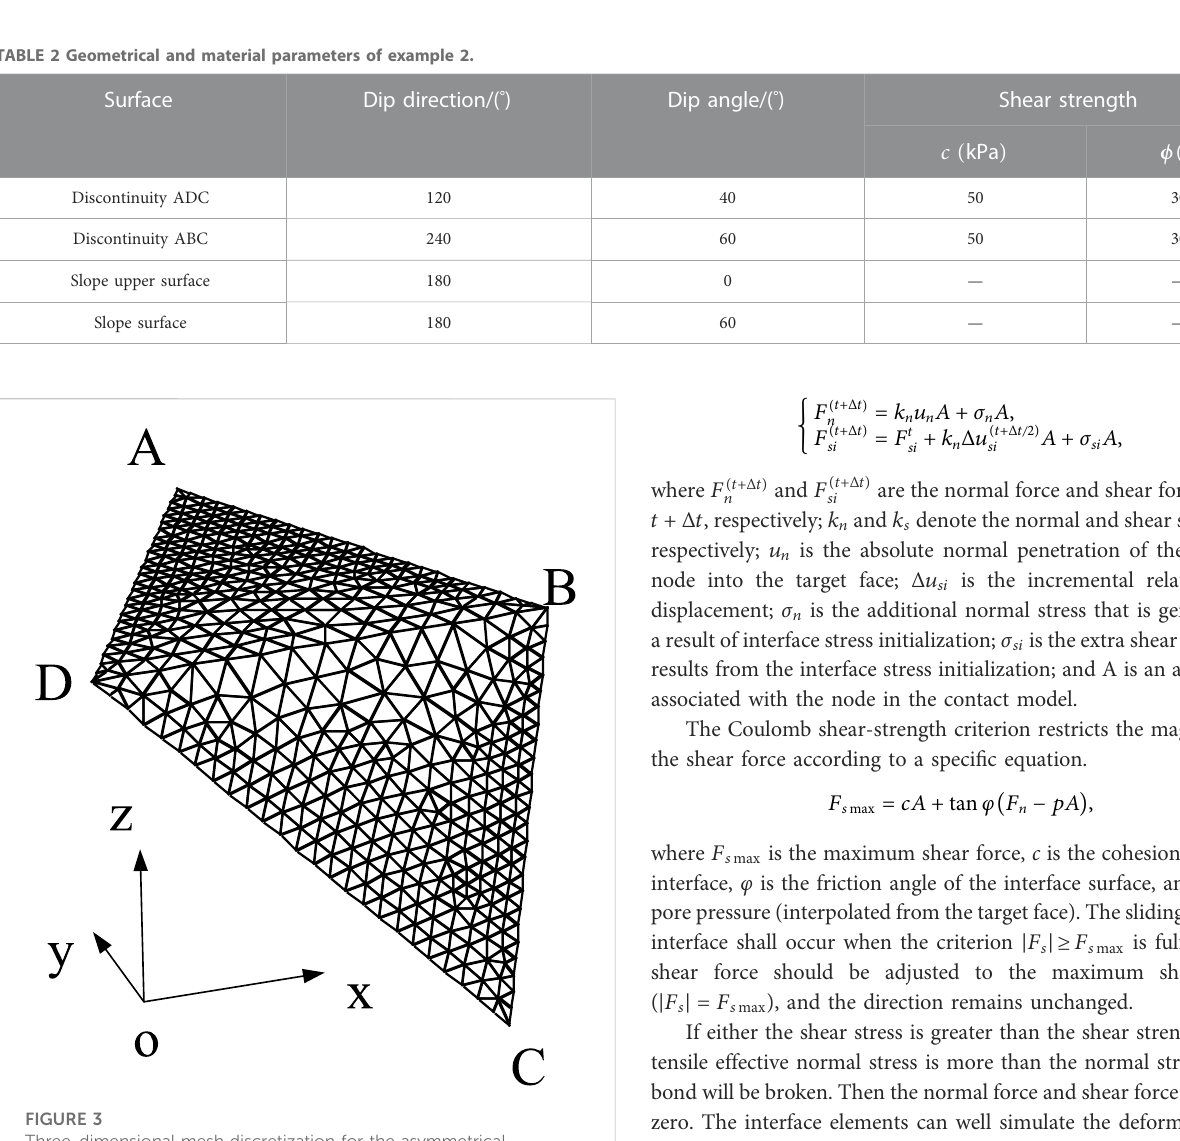
FIGURE 3 Three-dimensional mesh discretization for the asymmetrical wedge. 3) Example